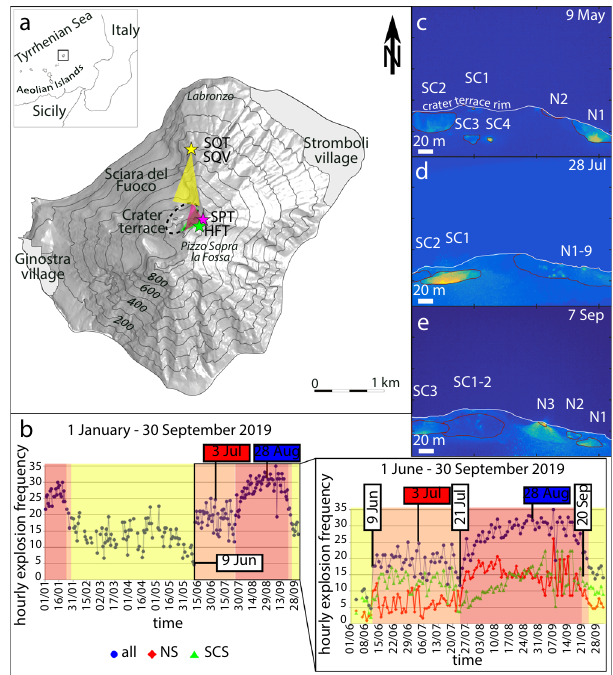
Fig. 1 Map of Stromboli Island and location of the explosive activity. a Map of Stromboli Island with the location of Stromboli Pizzo Thermal surveillance camera (SPT, magenta star), portable high-frequency thermal camera (HFT, green star) at Pizzo Sopra la Fossa (918 m a.s.l.), and the Stromboli ‘ Quattrocento ’ (~400 m a.s.l.) Thermal and Visible cameras (SQT and SQV, yellow star) along the Sciara del Fuoco. The fi eld of view of the crater terrace (dashed ellipse) of each camera is indicated by triangles. Gray areas: Stromboli and Ginostra villages. b Total hourly explosive frequency (HEF) per day in the period 1 January-30 September 2019, zoomed in the period 1 June-30 September for North Sector (NS) and South-Central Sector (SCS), respectively. Colored areas denote periods of medium (HEF ranging 5 – 15, yellow), high (HEF 15 – 25, orange), or very high (HEF > 25, red) activity levels. c , d , e Still frames from HFT video surveys from Pizzo on 9 May, 28 July and 7 September 2019, respectively, showing the morphology variations due to the two paroxysms and color-coded for the temperature scale (from blue to yellow tones marking increasing relative temperature). Numbers after letters indicate the different active vents in the N and SC